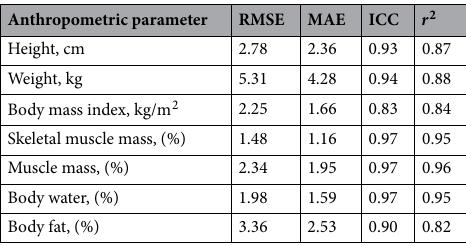
Table 3. Estimation results from the